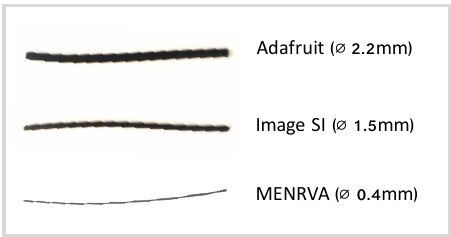
Figure 1. Comparison between the Adafruit, Image SI and Menrva sensors.